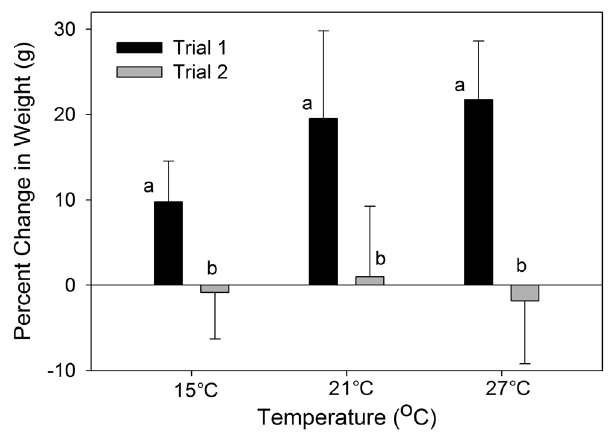
Figure 4. Mean 6 s.d. of MeHg concentrations of killifish (ng g 2 1 dry weight) exposed to 15 6 C, 21 6 C and 27 6 C for 30 days. MeHg concentrations were highest in killifish exposed to 27 u C. Different letters indicate significant differences.